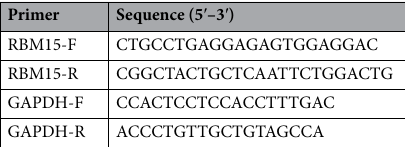
Table 1. Primer sequences of GAPDH and